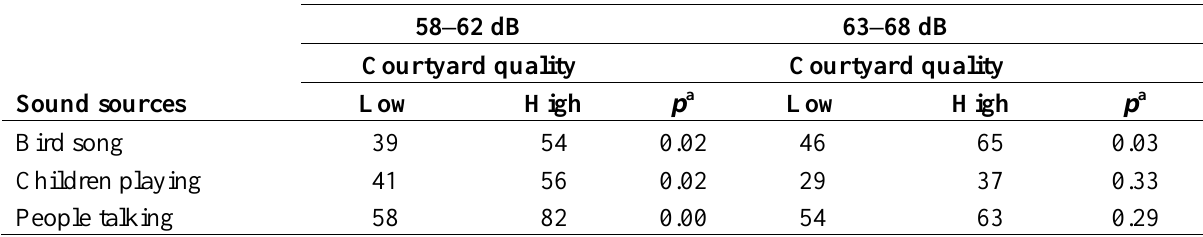
Table 5 . Identification of sound sources (%) in relation to courtyard quality and sound